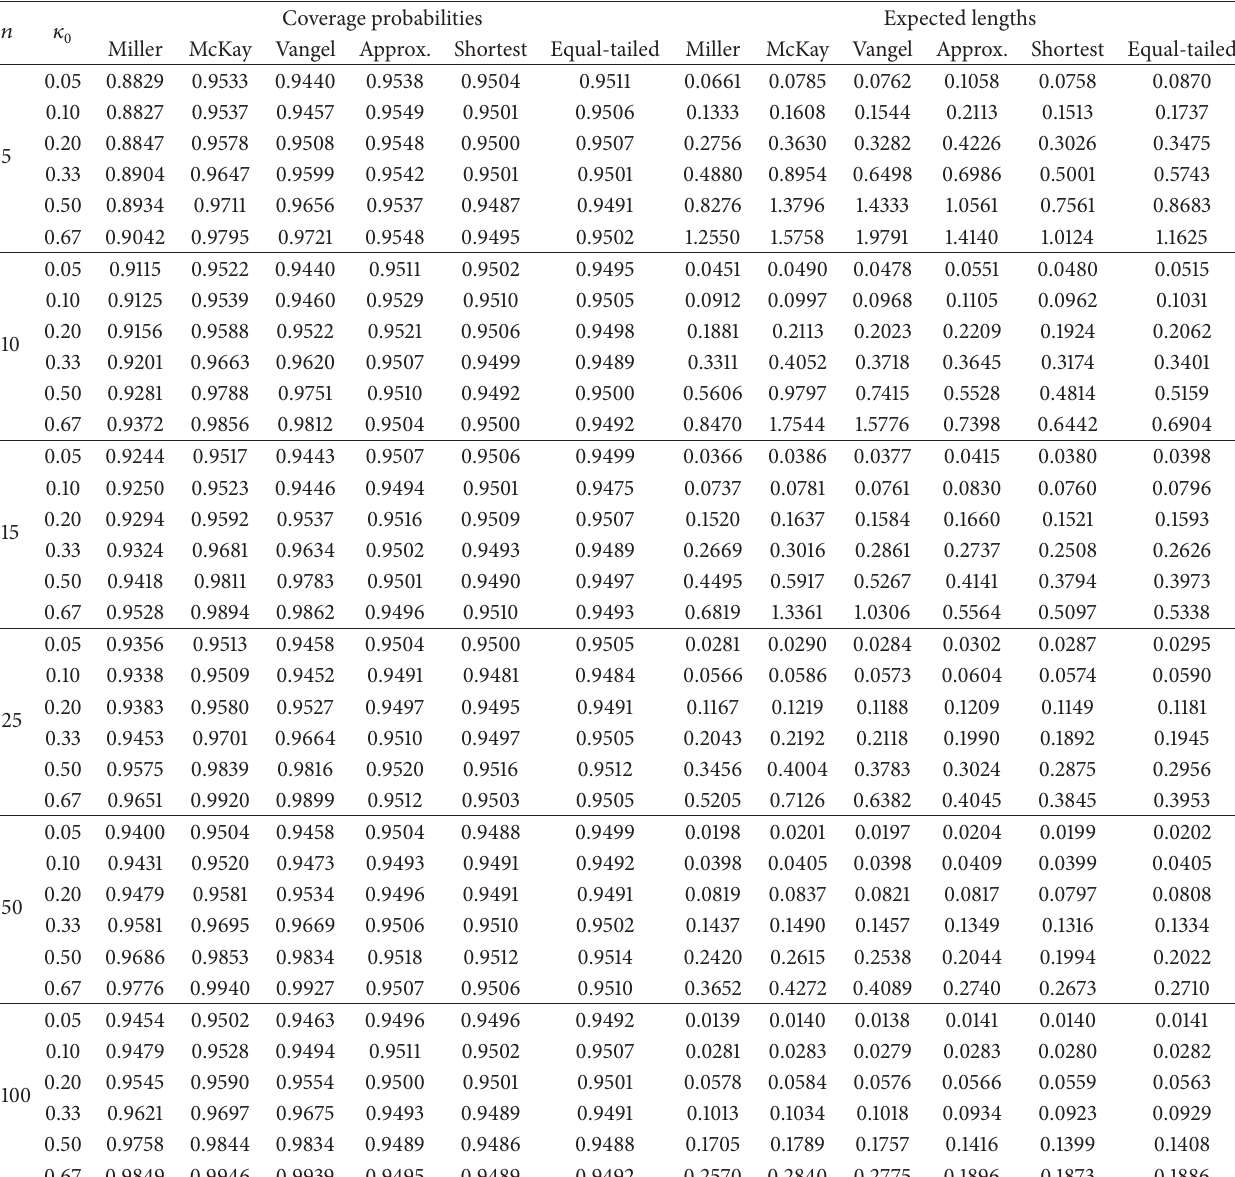
Table 3: The estimated coverage probabilities and expected lengths of 95% confidence intervals for the coefficient of variation in a normal distribution with a known population